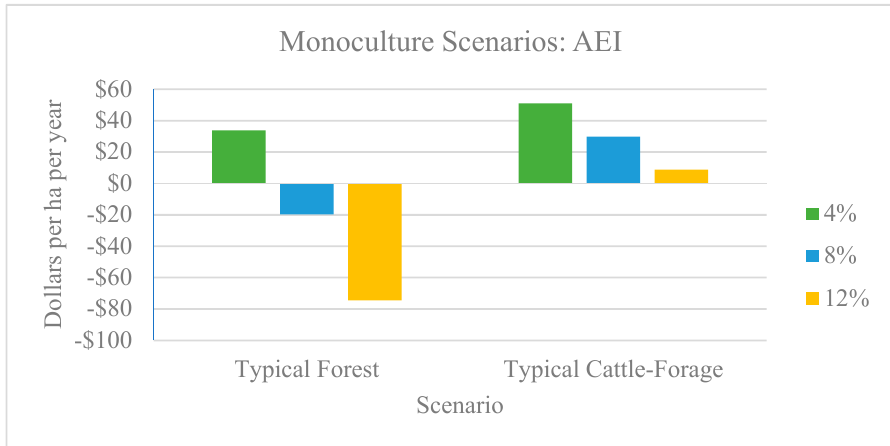
Figure 1. Annual equivalent income (AEI) of traditional forest and cattle systems.